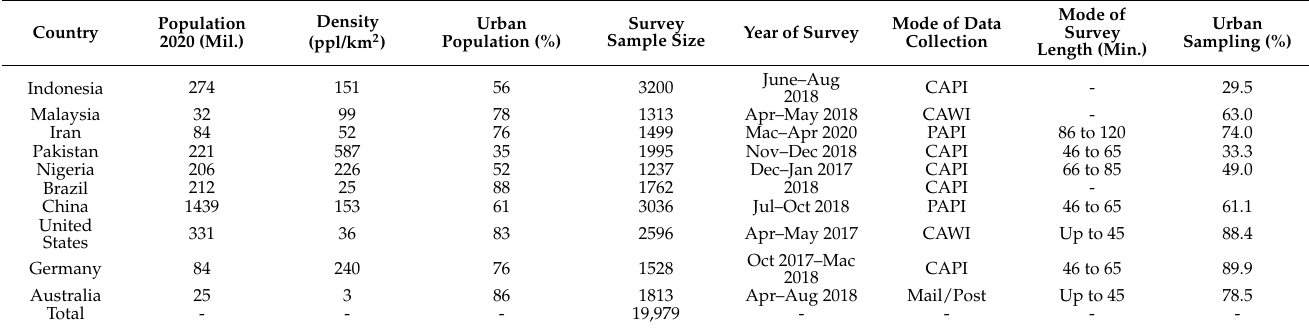
Table 2. Population, sample size, and year of survey. Source: [26,29,31].